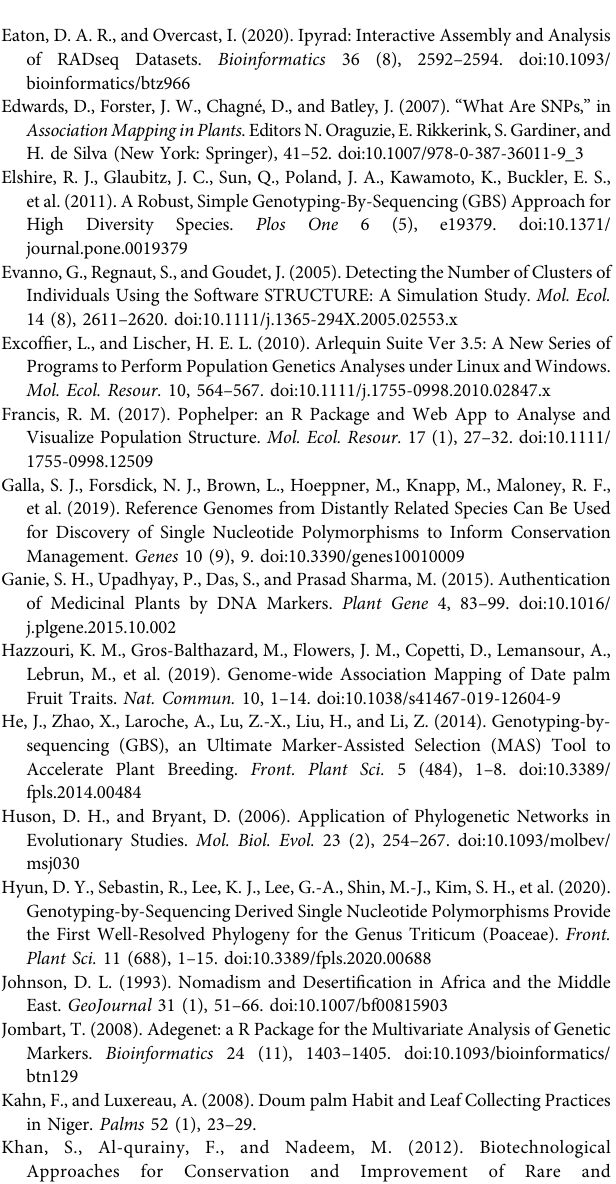
Supplementary Figure S3 | Optimal Delta k values for different k values inferred during STRUCTURE analysis of Kenyan Hyphaene compressa showing the optimal delta k at k (cid:1) 2 for the reference-based assembly (A) and the de_novo based assembly (B) . Supplementary Figure S4 | STRUCTURE bar plot of admixture model population assignment of 96 Hyphaene compressa accessions from Kenya showing three clusters based on 2096 Single Nucleotide Polymorphisms (SNPs) for the de-novo assembly (A) and 23416 SNPs based on reference assembly (B) . A combination of different colors represents admixed populations. In these structure plots, Tharaka and Tana River accessions have been placed in one cluster. Supplementary Figure S5 | Unrooted UPGMA distance tree inferred using 23416 SNPs based on the reference based assembly of H. compressa accessions. Supplementary Figure S6 | Migration rates between Tharaka, Tana River and Kwale using MIGRATE-n software. The direction of the arrow indicate the direction of gene fl